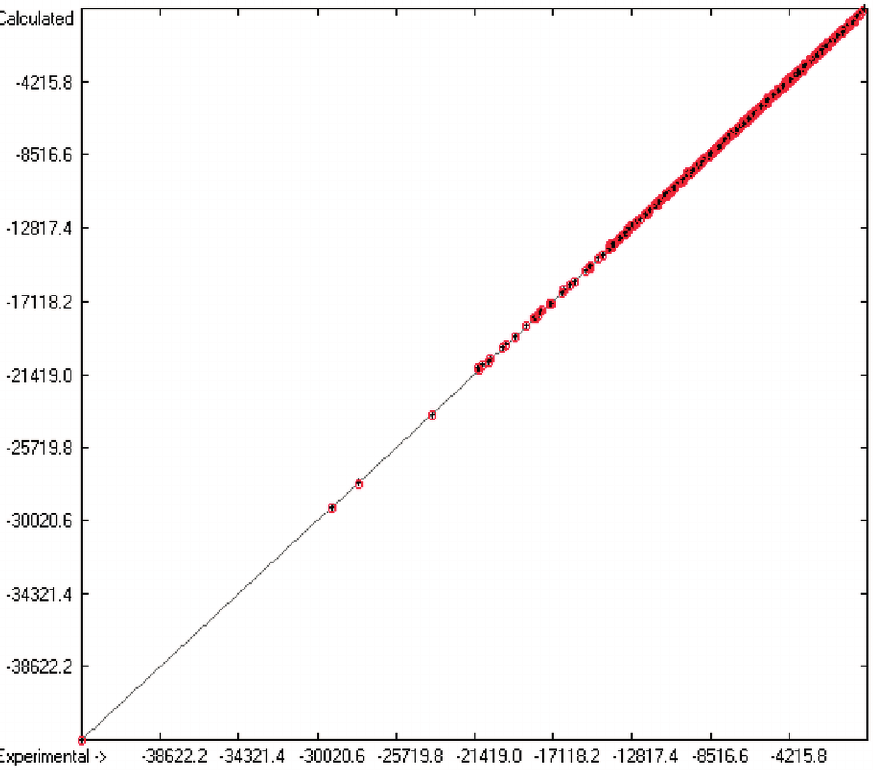
Figure 1. Correlation diagram of heat-of-combustion data (10-fold cross-validated: N = 2031, Q 2 = 0.9999, slope =